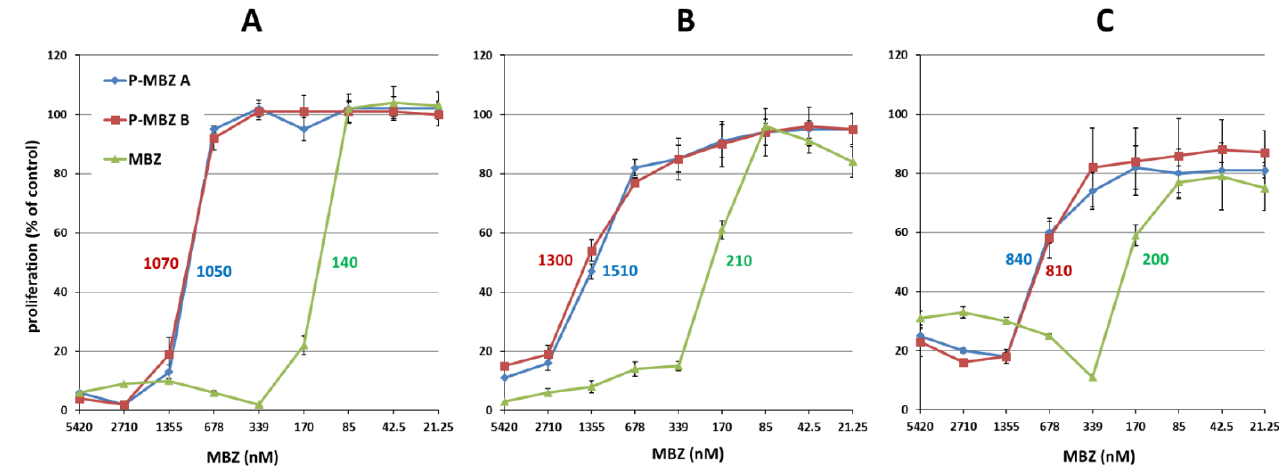
Figure 4. Cytostatic activity of polymer-bound mebendazole conjugates. Cytostatic activity of HPMA copolymer-bound mebendazole conjugates ( P-MBZ-A and P-MBZ-B ) and free mebendazole (MBZ) in EL-4 ( A ), LL2 ( B ) and CT-26 ( C ) murine cancer cell lines in vitro as determined by a [ 3 H]-thymidine incorporation assay after 72 h of incubation. The calculated IC 50 values (nM) are shown inside the graphs for all samples. Each experimental condition was performed in quadruplicate, and the results are shown as the proliferation of exposed cells relative to the controls (untreated cells) ± SD. The experiment was repeated with similar